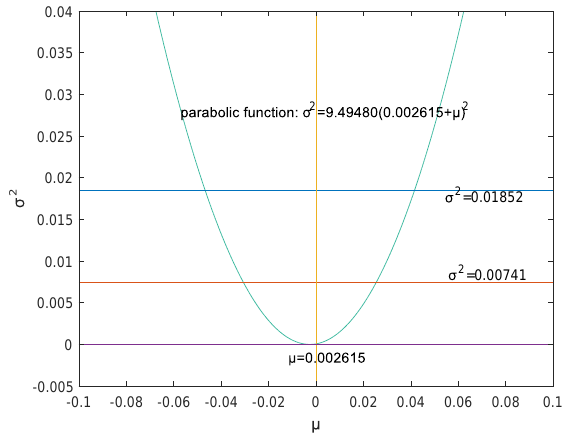
Figure 10. The joint confidence region of ( µ , σ 2 ) by area minimization